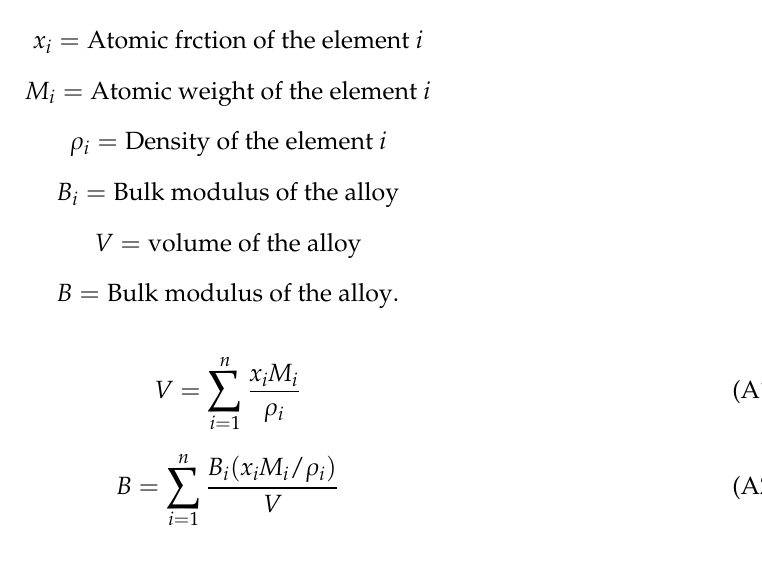
Table A4. Compositions, cell volume, bulk modulus and ratio between the bulk modulus and cell volume for AB2 C14 Lave